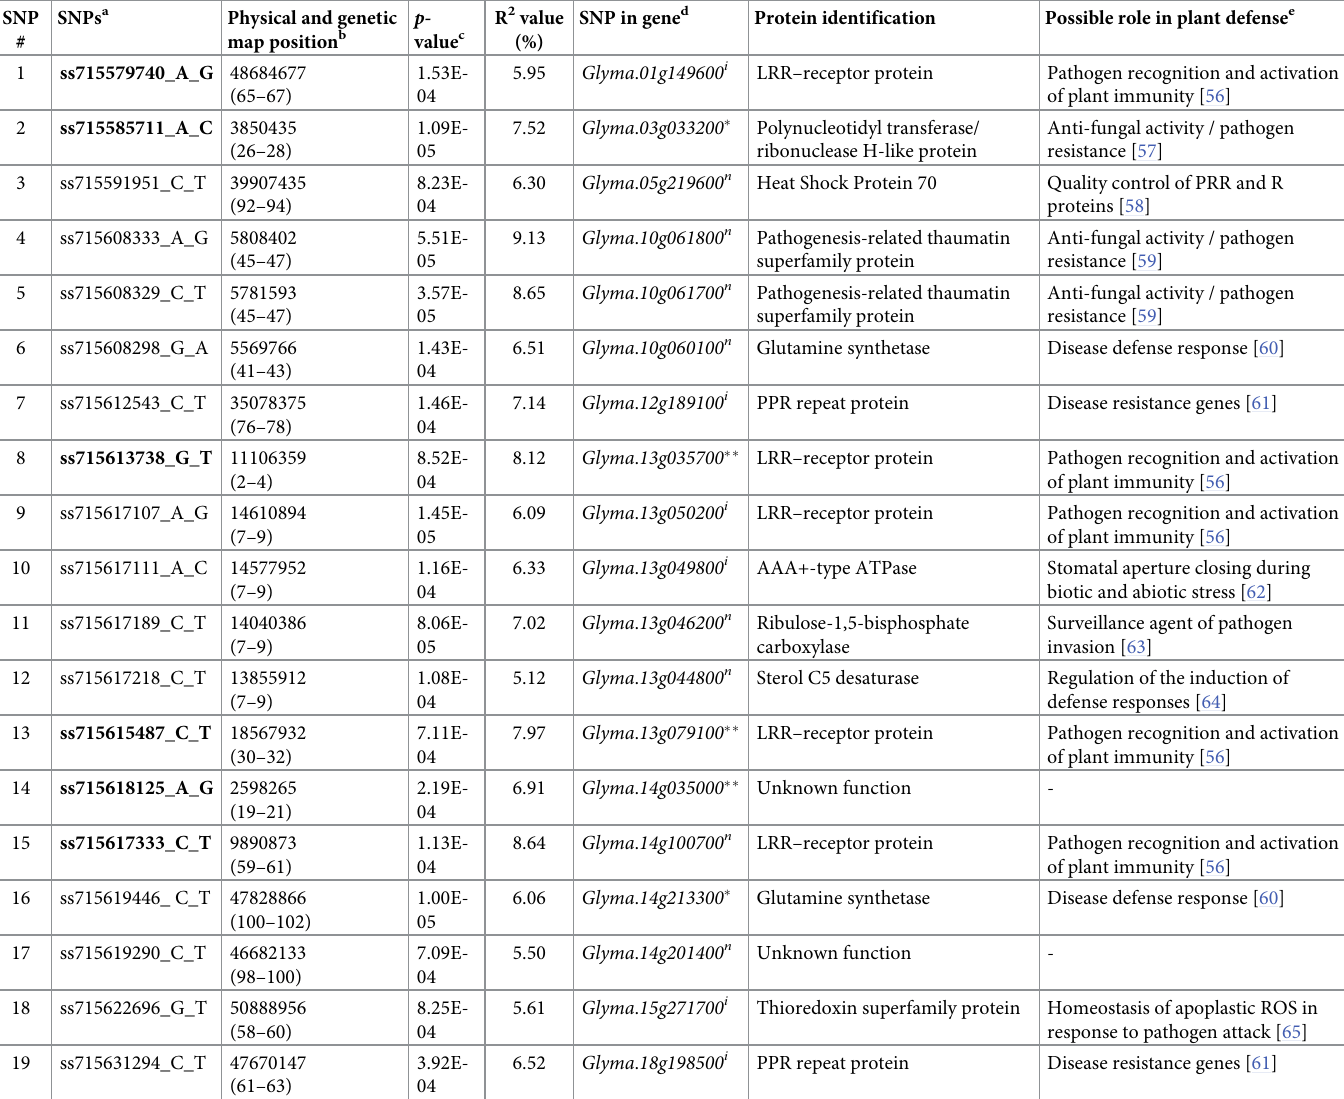
Table 1. Details of 19 SNPs that are associated with foliar SDS